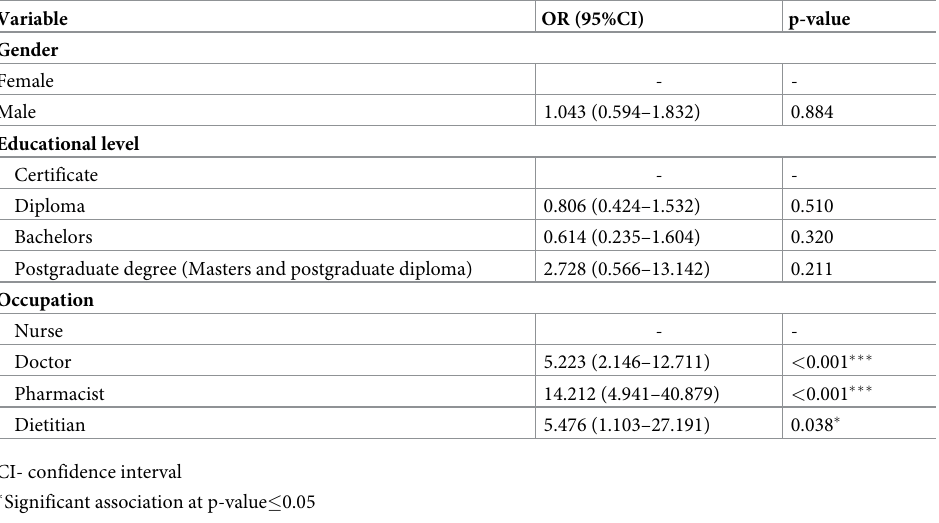
Table 4. Binary logistic regression analysis of factors associated with knowledge of drug-food interactions (N = 457).